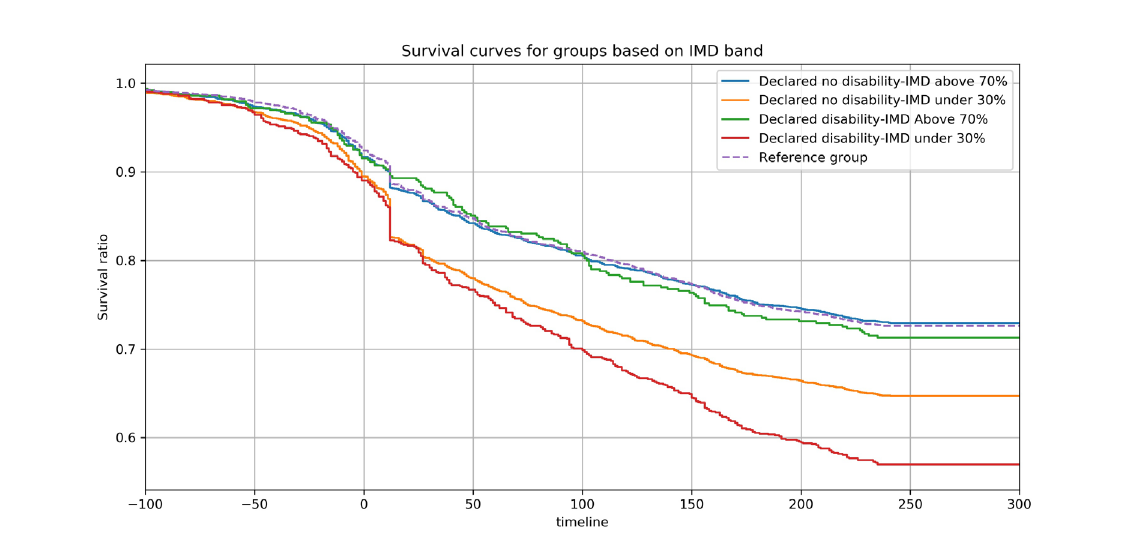
Figure 3 Survival Curves for Groups With and Without Declared Disability in High and Low IMD